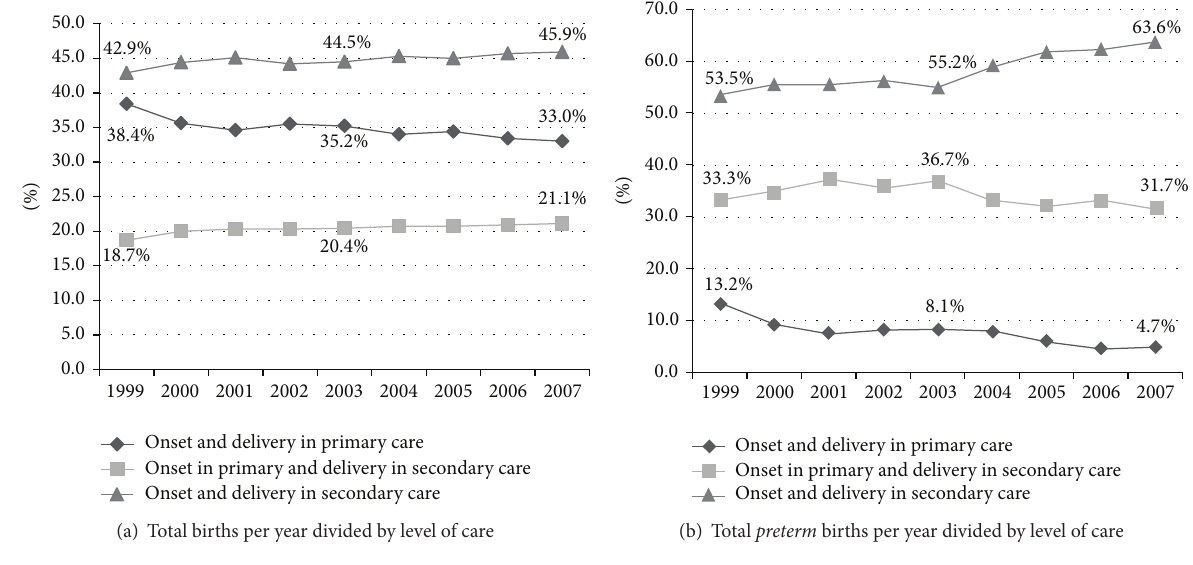
Figure 3: Trends over